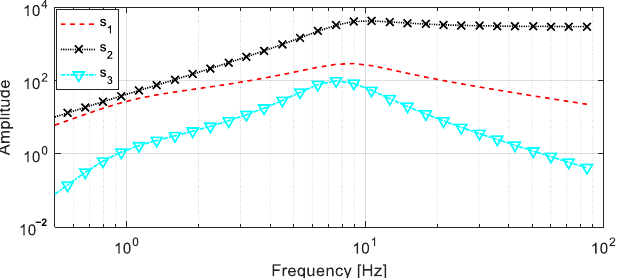
Figure 5. Amplitudes of the acceleration frequency responses of the vehicle at the measurement points to the unit vertical displacement of the rear wheel contact point.